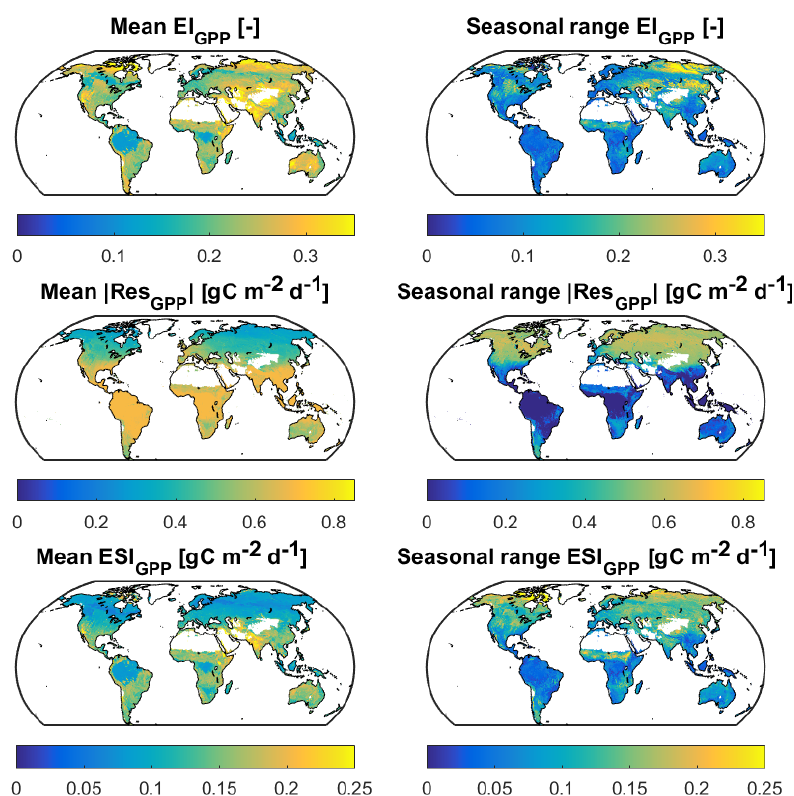
Figure 10. Mean annual (2001–2015) and seasonal range (8d time step) of the extrapolation index (EI), the expected mean absolute error of machine learning predictions, and the extrapolation severity index (ESI, product of the previous two) (see Fig. S2 for details) for GPP from